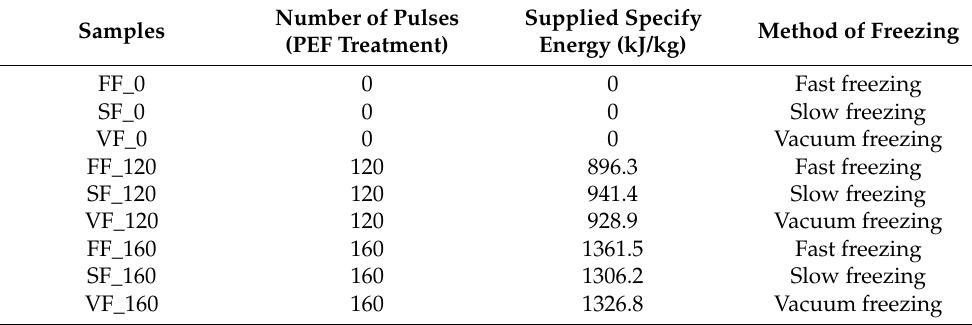
Table 1. Description of the freeze-dried